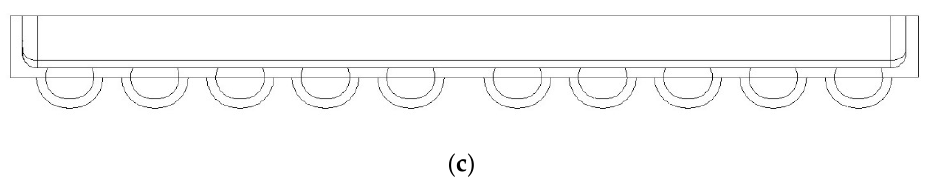
Figure 6. Liftable sliding seed case. ( a ) 3D diagram. ( b ) Object diagram. ( c ) Cross-sectional view of the seed case. Liftable sliding seed case structure composition: ① front convex block, ② main bracket, ③ sub-bracket, ④ sliding stand, ⑤ connecting rod, ⑥ cylinder, ⑦ case body, ⑧ seed storage hole.